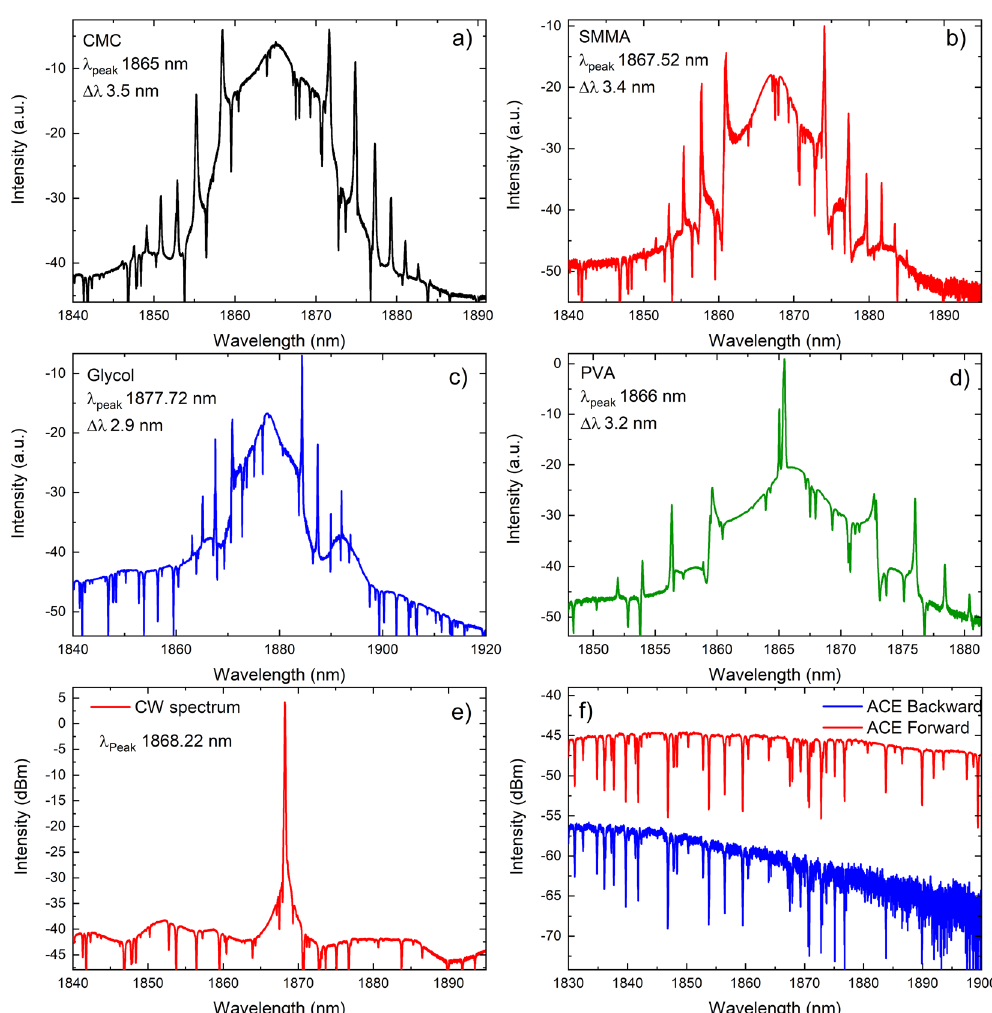
Figure 1. Optical spectrums obtained for various conditions. Mode-locked spectrum obtained by using ( a ) CMC, ( b ) SMMA, ( c ) Glycol and ( d ) PVA. CW spectrum obtained without any SA, Fig. 5(e). Forward and Backward ACE spectrums, ( f